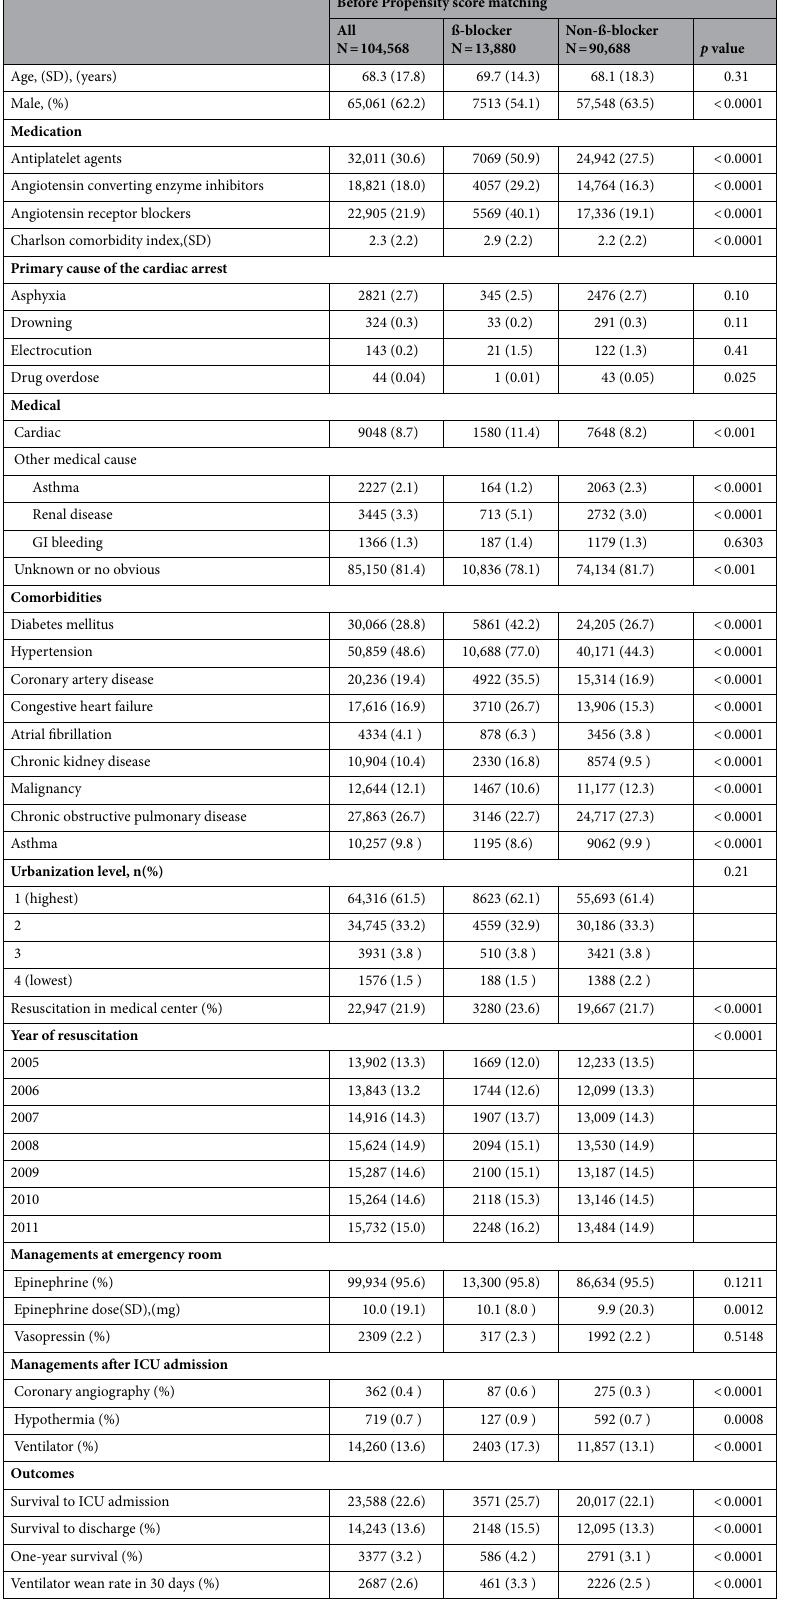
Table 1. Baseline characteristics, management and outcomes of patient with/without ß-blocker use before